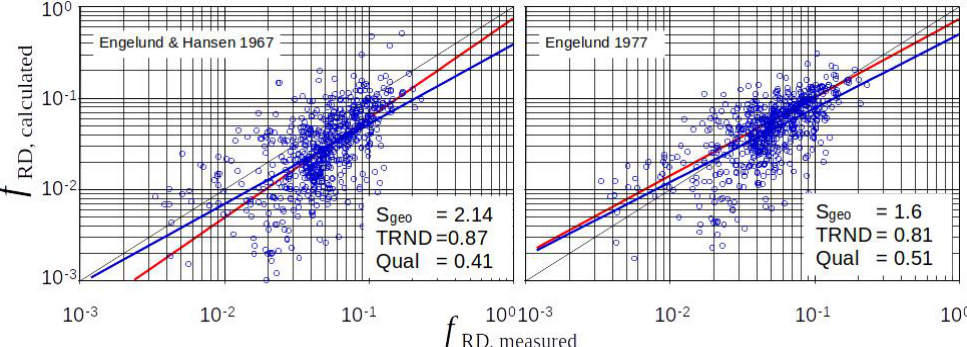
Figure 9. Approaches via energy loss at a sudden widening (Borda–Carnot) in the case of ripples and dunes (red trendline: ripples, and blue trendline: all